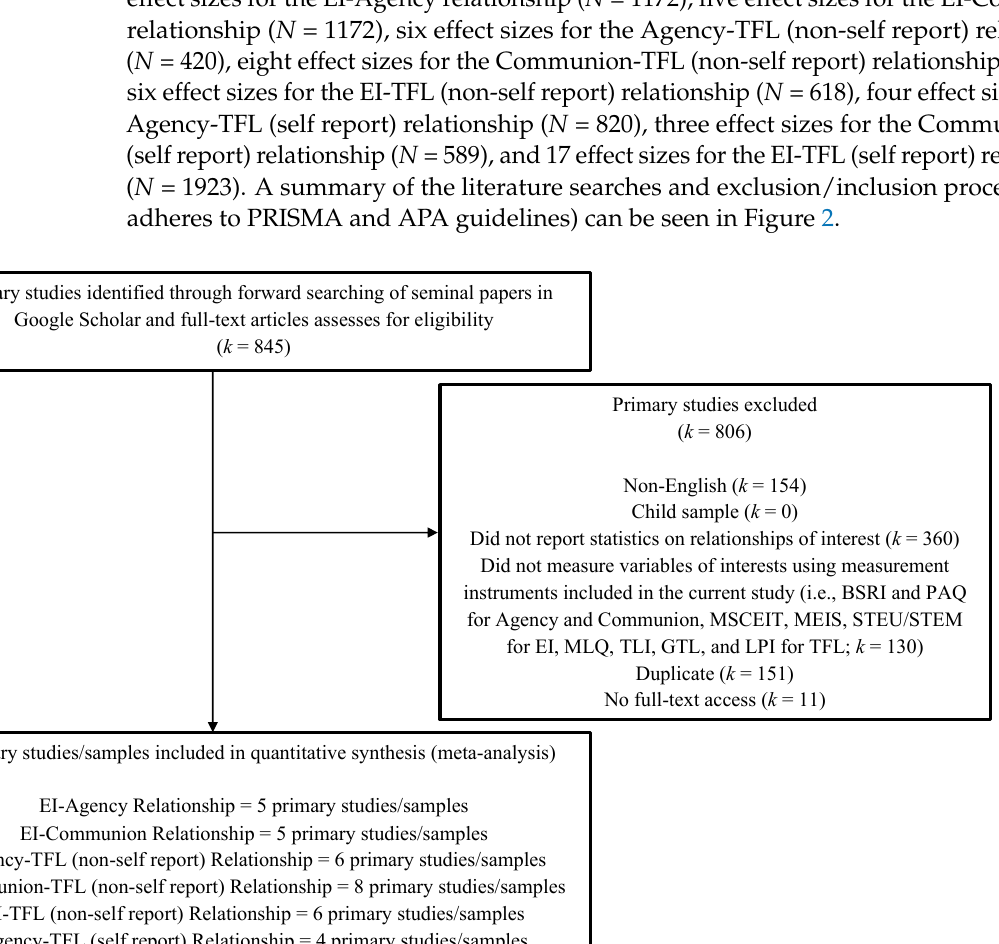
Figure 2. Flow Chart for Meta-Analytic Literature Search.